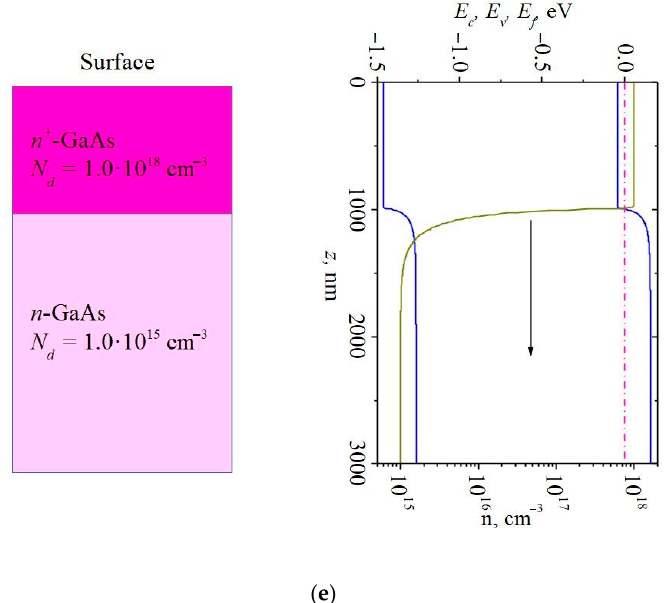
Figure A1. Cross-sections of the investigated semiconductor structures and their energy band diagrams with electron density distribution (in olive). ( a ) Selectively doped AlGaAs/GaAs structure with a triangular GaAs quantum well (TQW). ( b ) AlGaAs/GaAs structure with a rectangular GaAs quantum well (RQW). ( c ) GaAs/InGaAs structure with a rectangular InGaAs quantum well (InRQW). ( d ) Thin epitaxial heavily doped GaAs layer (THG). ( e ) Epitaxial structure with a thick lightly doped GaAs layer (TLG).